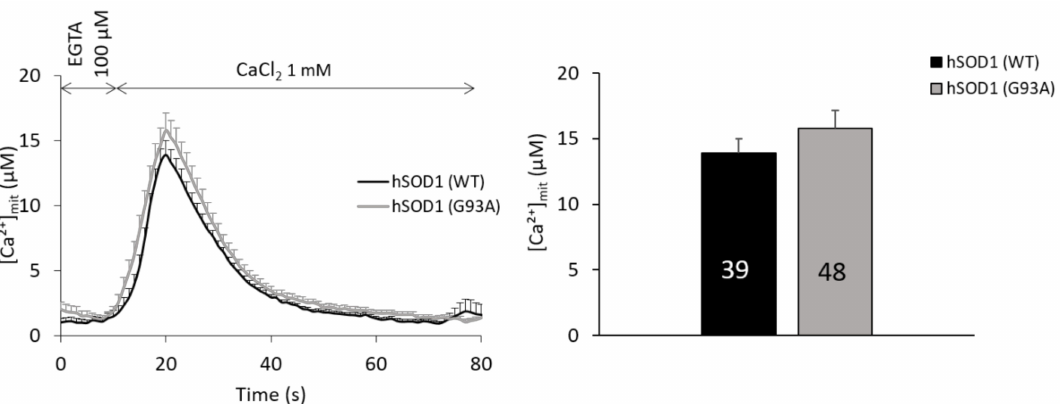
Figure 5. No di ff erence is observed in SOCE-evoked mitochondrial Ca 2 + transients in primary astrocytes expressing WT or mutant (G93A) hSOD1. Mitochondrial Ca 2 + transients induced by SOCE activation were measured in hSOD1(WT) or hSOD1(G93A) astrocytes by means of lentivirally-delivered AEQ mit targeted to the mitochondrial matrix. The average traces reported on the right and the corresponding peak values reported in the bar diagram on the left provide comparable results for the two astrocyte populations (unpaired two-tailed Student’s t-test). Peak values are: 13.88 ± 1.09 µ M in hSOD1(WT), 15.76 ± 1.38 µ M in hSOD1(G93A). Other experimental details are as in the legend to Figure